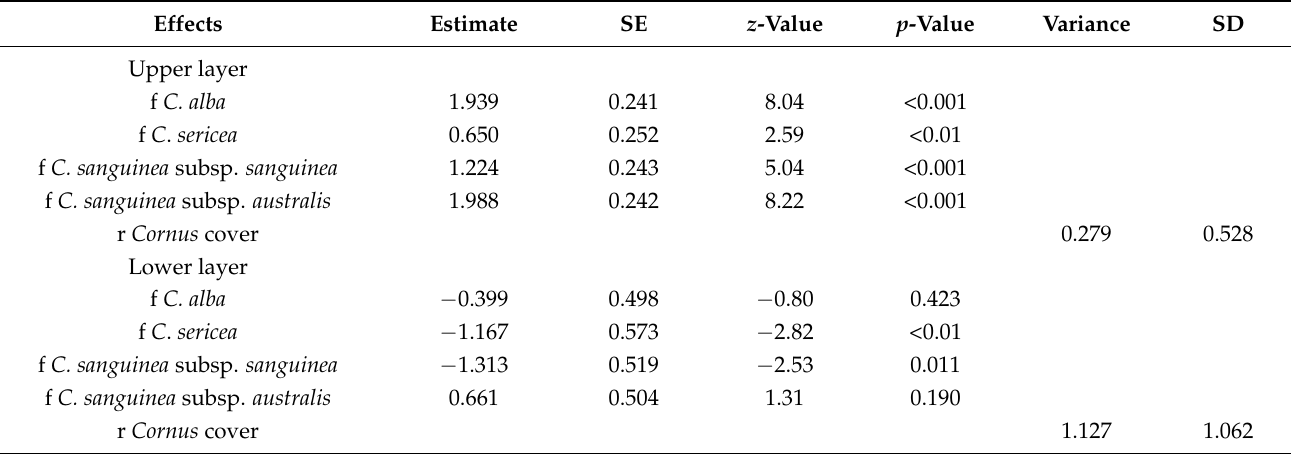
Table 5. GLMM results for the intact seed density in the upper (0–5 cm) and lower (5–10 cm) soil layers. Taxa were considered as a fixed effect (f) and the cover of Cornus was considered as a random effect (r). SE—standard error; SD—standard